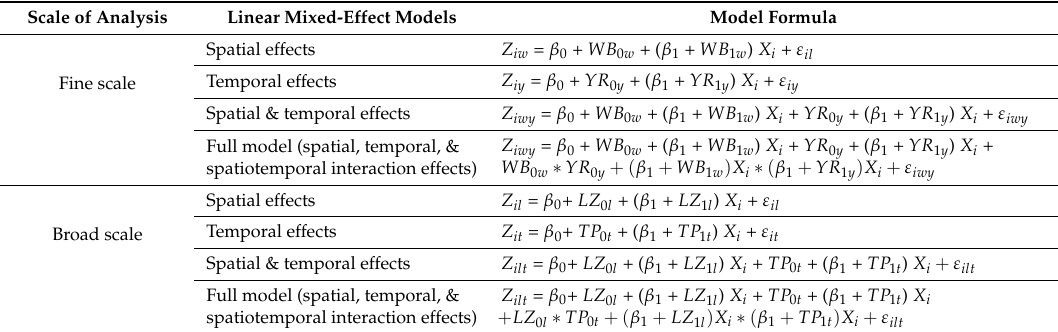
Table 1. Description of the LMEM’s used to capture spatial, temporal and spatiotemporal variation in mercury bioaccumulation at two distinct scales of analyses for Walleye and Northern Pike. Both response ( Z , mercury concentration) and fixed-effect covariate ( X , fish length) are log-transformed throughout but is not shown explicitly in the model